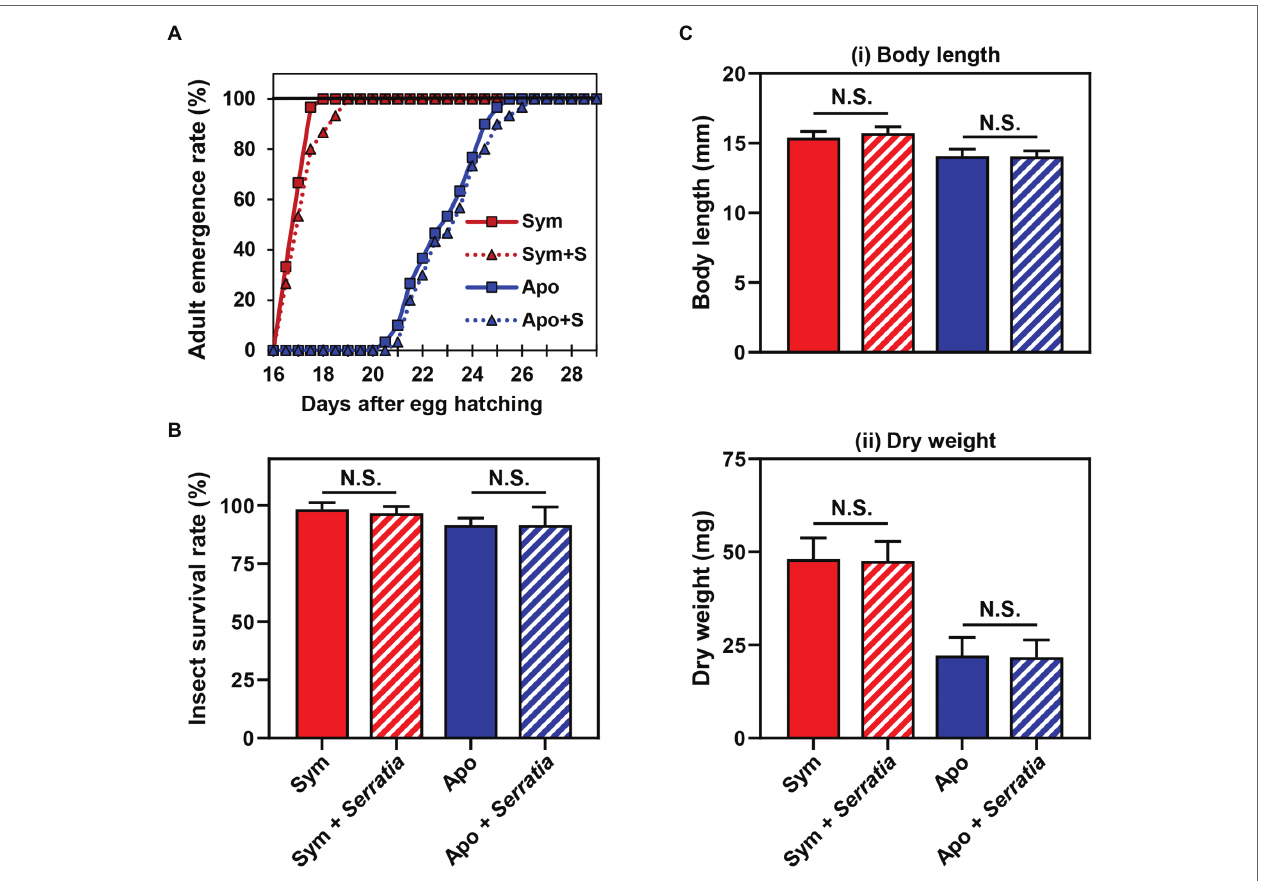
FIGURE 2 | Effects of orally infected Serratia marcescens on Riptortus pedestris. Comparison of the (A) developmental rate, (B) survival rate, and (C) fitness parameters of male R. pedestris insects after oral infection with S. marcescens . The fitness effects of each group were analyzed by measuring the (i) body length and (ii) dry weight of male R. pedestris 5 days after adult emergence. Error bars indicate the SD of the mean ( n = 30). (N.S., not